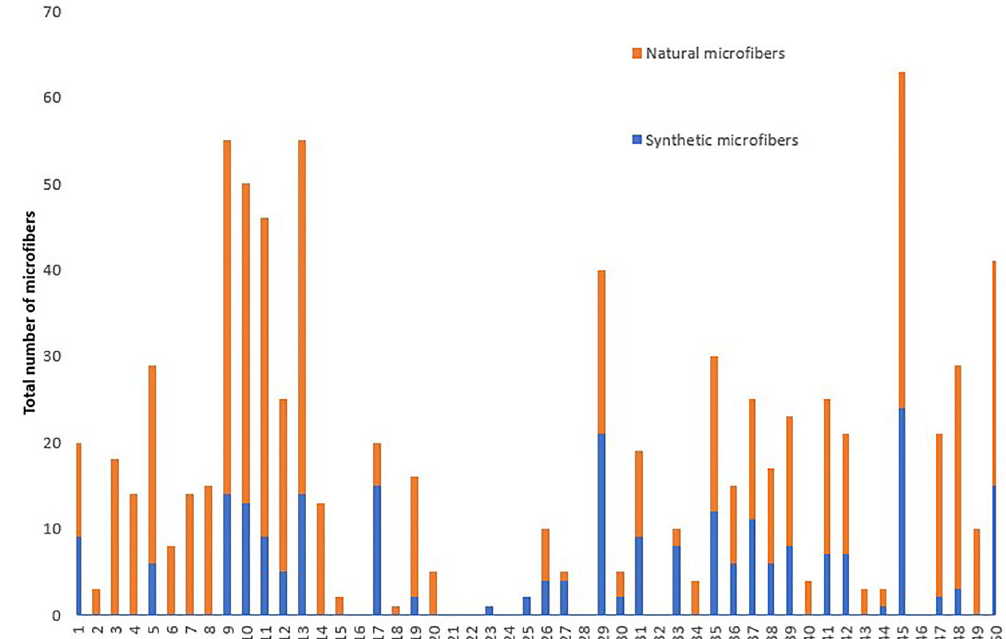
Figure 1. Discrimination into synthetic and naturals microfibers of the total number of microfibers found in analyzed mussels.